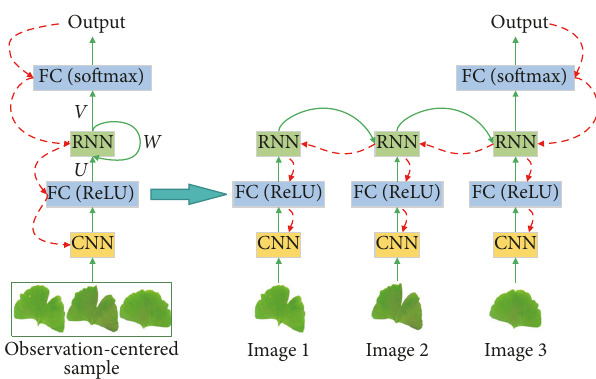
Figure 1: The C-RNN model for observation-centered plant identi- fication. The green arrows are the forward inference and the dashed red arrows are the truncated back propagation through